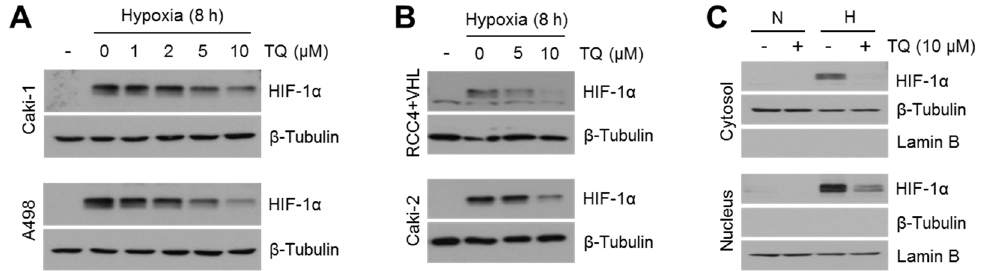
Figure 2. Hypoxia-inducible factor-1 α (HIF-1 α ) is decreased by thymoquinone (TQ) in hypoxic renal cancer cells. ( A ) Caki-1 and A498 renal cancer cells were incubated with various concentrations of TQ (0, 1, 2, 5, or 10 µ M) as indicated for 8 h under hypoxia. Protein expression levels were measured by western blotting as described in Materials and Methods. ( B ) RCC4 + pVHL and Caki-2 cells were incubated with TQ as indicated upon hypoxia for 8 h. ( C ) Caki-1 cells treated with 10 µ M of TQ upon normoxia or hypoxia for 8 h were used for obtaining cytoplasmic or nuclear protein samples. Nuclear proteins were isolated using high concentration of sodium chloride-based hypertonic buffer. β -tubulin and lamin B proteins were used as a loading control for cytoplasmic proteins and nuclear proteins.